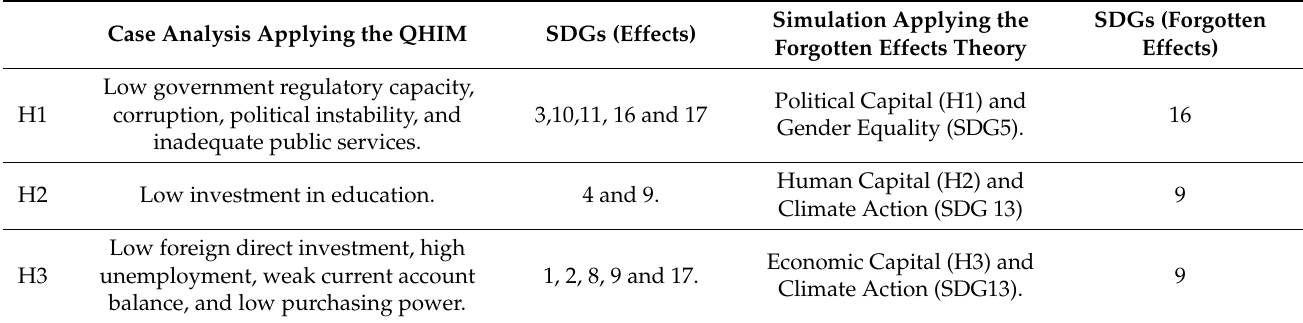
Table A5. Main study